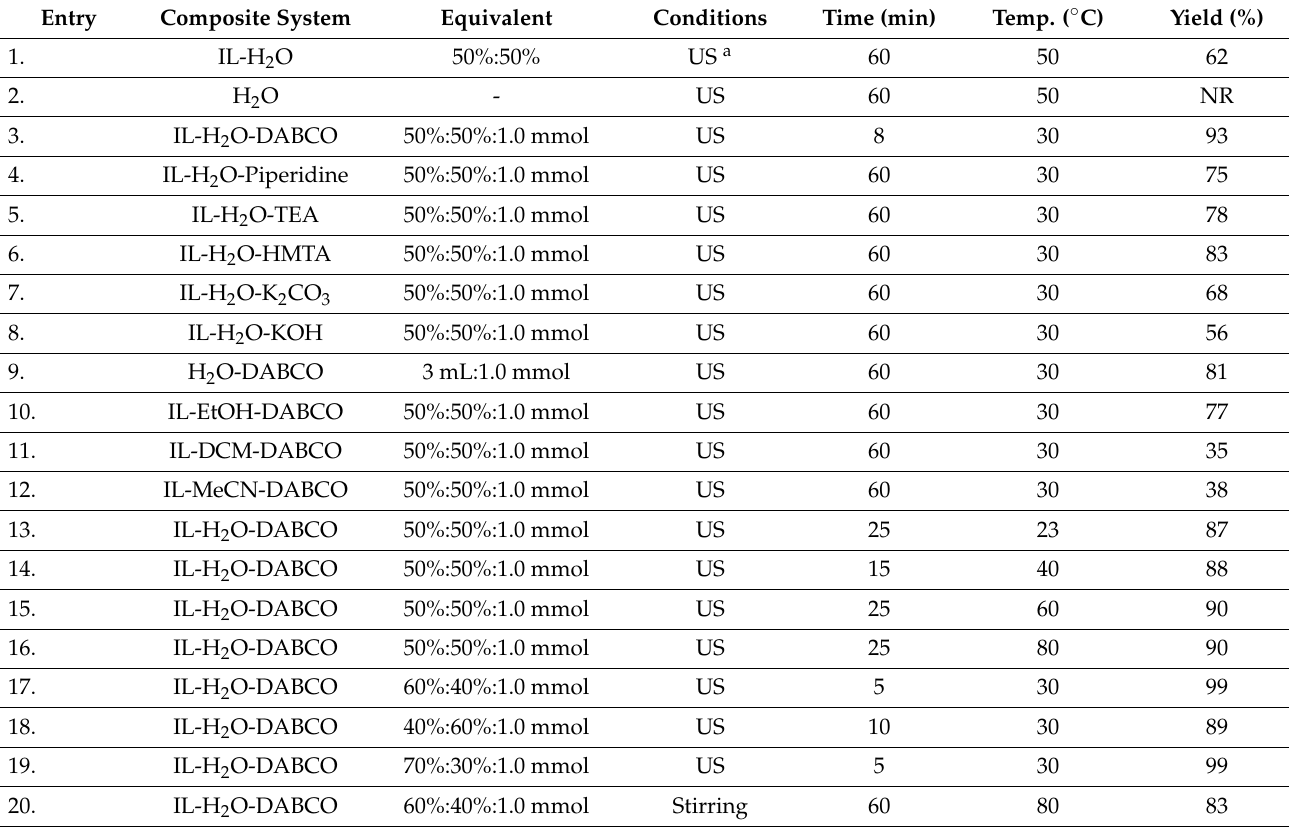
Table 1. Optimization of the reaction conditions for the assembly of